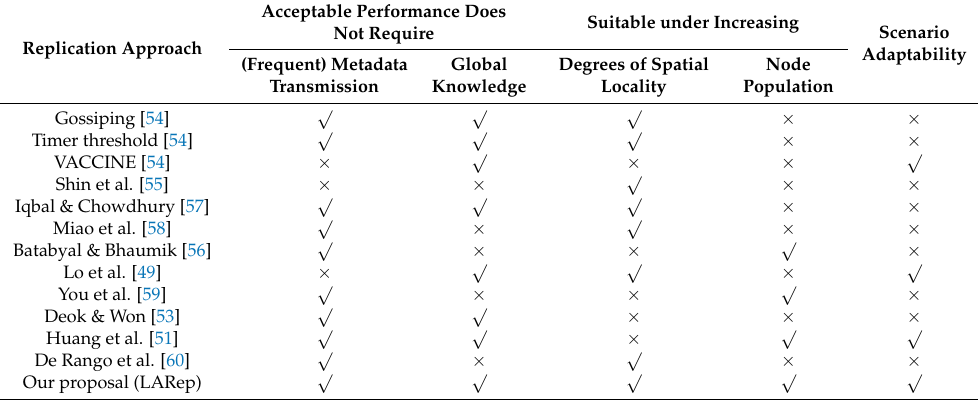
Table 2. Replication approaches for reducing transmission overhead and their main